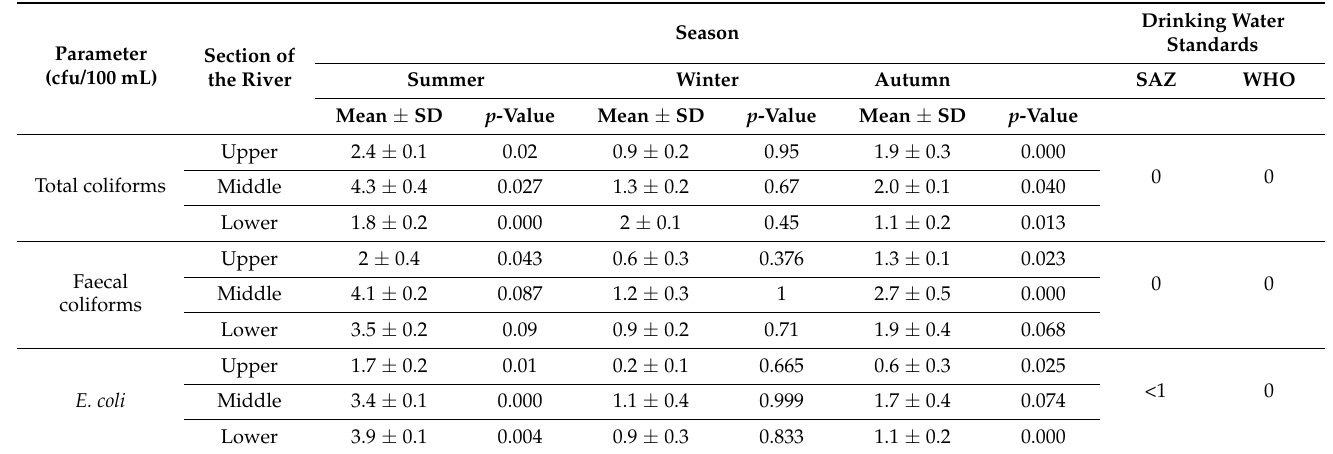
Table 3. Bacteriological parameters in river water